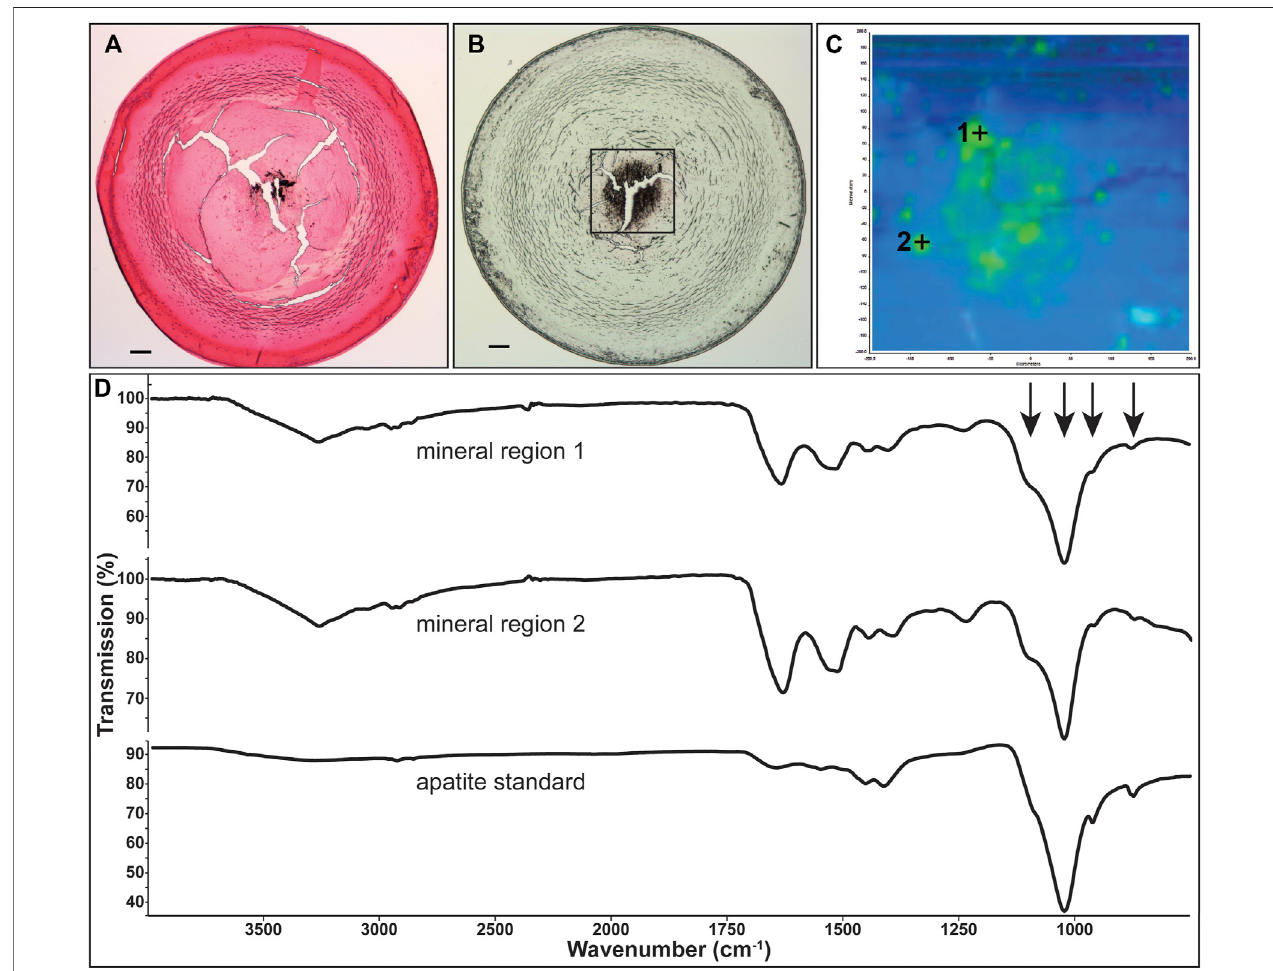
FIGURE 6 | Identi fi cation of mineral type in Cx50D47A lenses. (A) Image showing Yasue staining of a section from the lens of the 102-day-old homozygous Cx50D47A male mouse shown in Figure 2E . The stained material that appears black corresponds to calci fi cations. (B) Image of an unstained section of the same lens on low emissivity glass used for infrared imaging. (C) Image shows the infrared signal map of the boxed region shown on (B) generated by collecting 4,096 infrared spectra with apixelresolution of6.24 μ m. Green areasare mineral regions and blue areas are protein regions. (D) Graphs show the spectra oftwo mineral regions and the apatite standard. Arrows point to features characteristic of apatite mineral in the lens. The scale bars in (A,B) represent 100 µm.